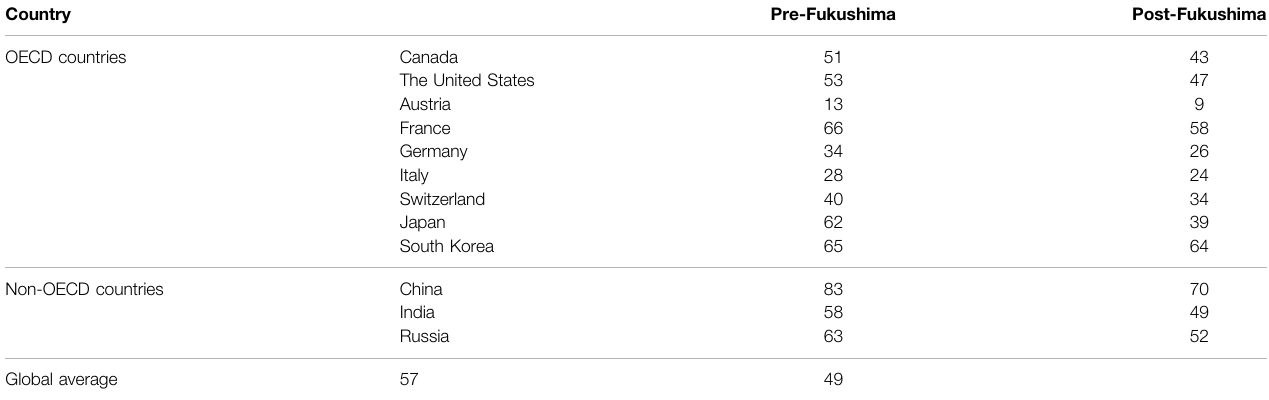
TABLE 1 | Percentage changes in positive opinion toward nuclear power pre- and post-Fukushima (Hayashi and Hughes (2013)).